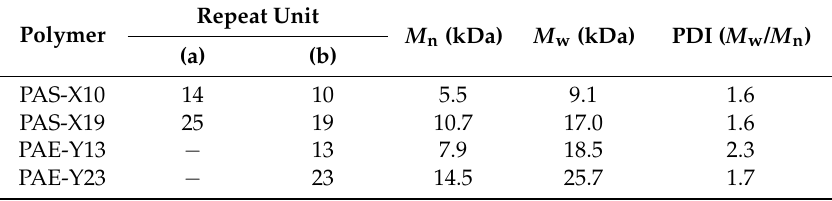
Table 1. Repeat units, molecular weights ( M n and M w ) and PDI ( M w / M n ) of PAS and PAE oligomers.